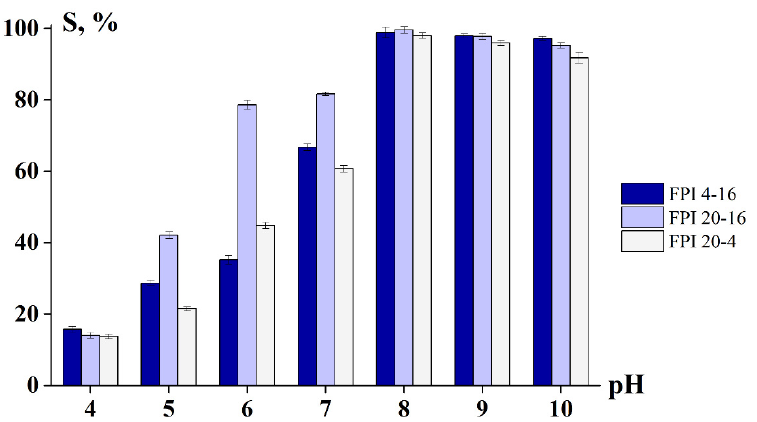
Figure 4. Influence of pH on the solubility of fish protein isolate (FPI). Sample designations are shown on the graph.